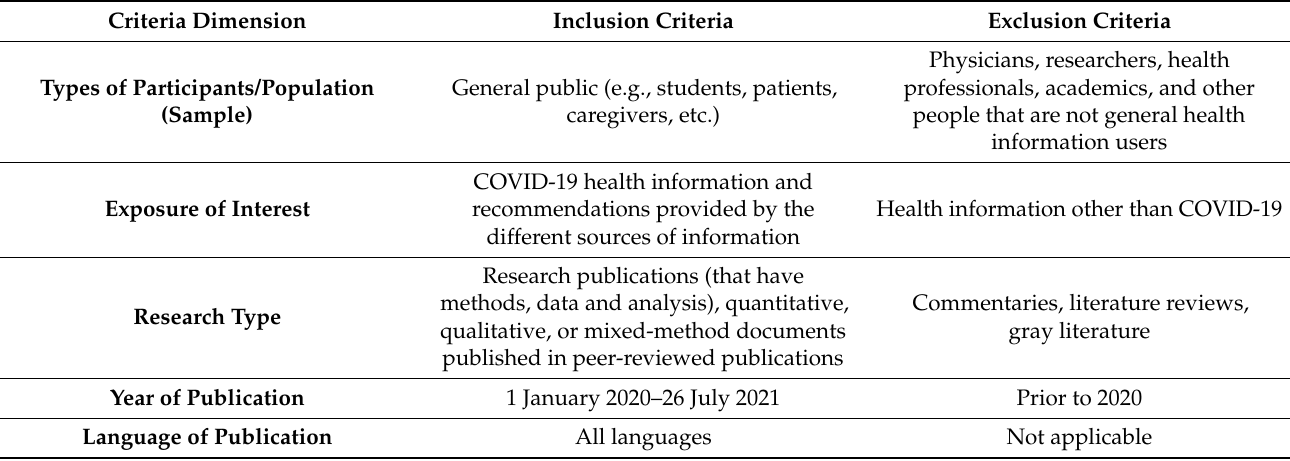
Table 1. Selection criteria for studies included in the